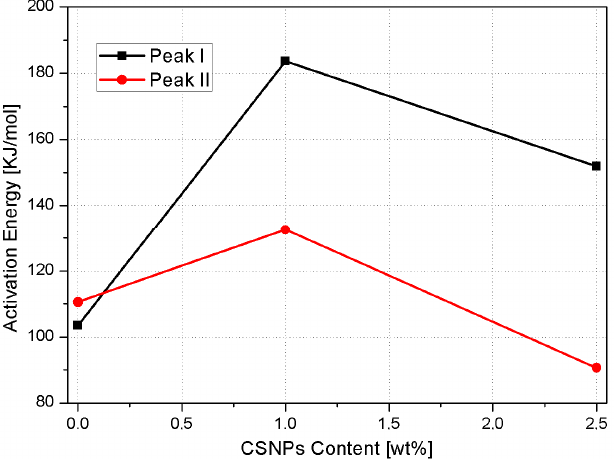
Figure 10. Kissinger Method applied to the RTM6 + 1 wt% CSNPs sample.